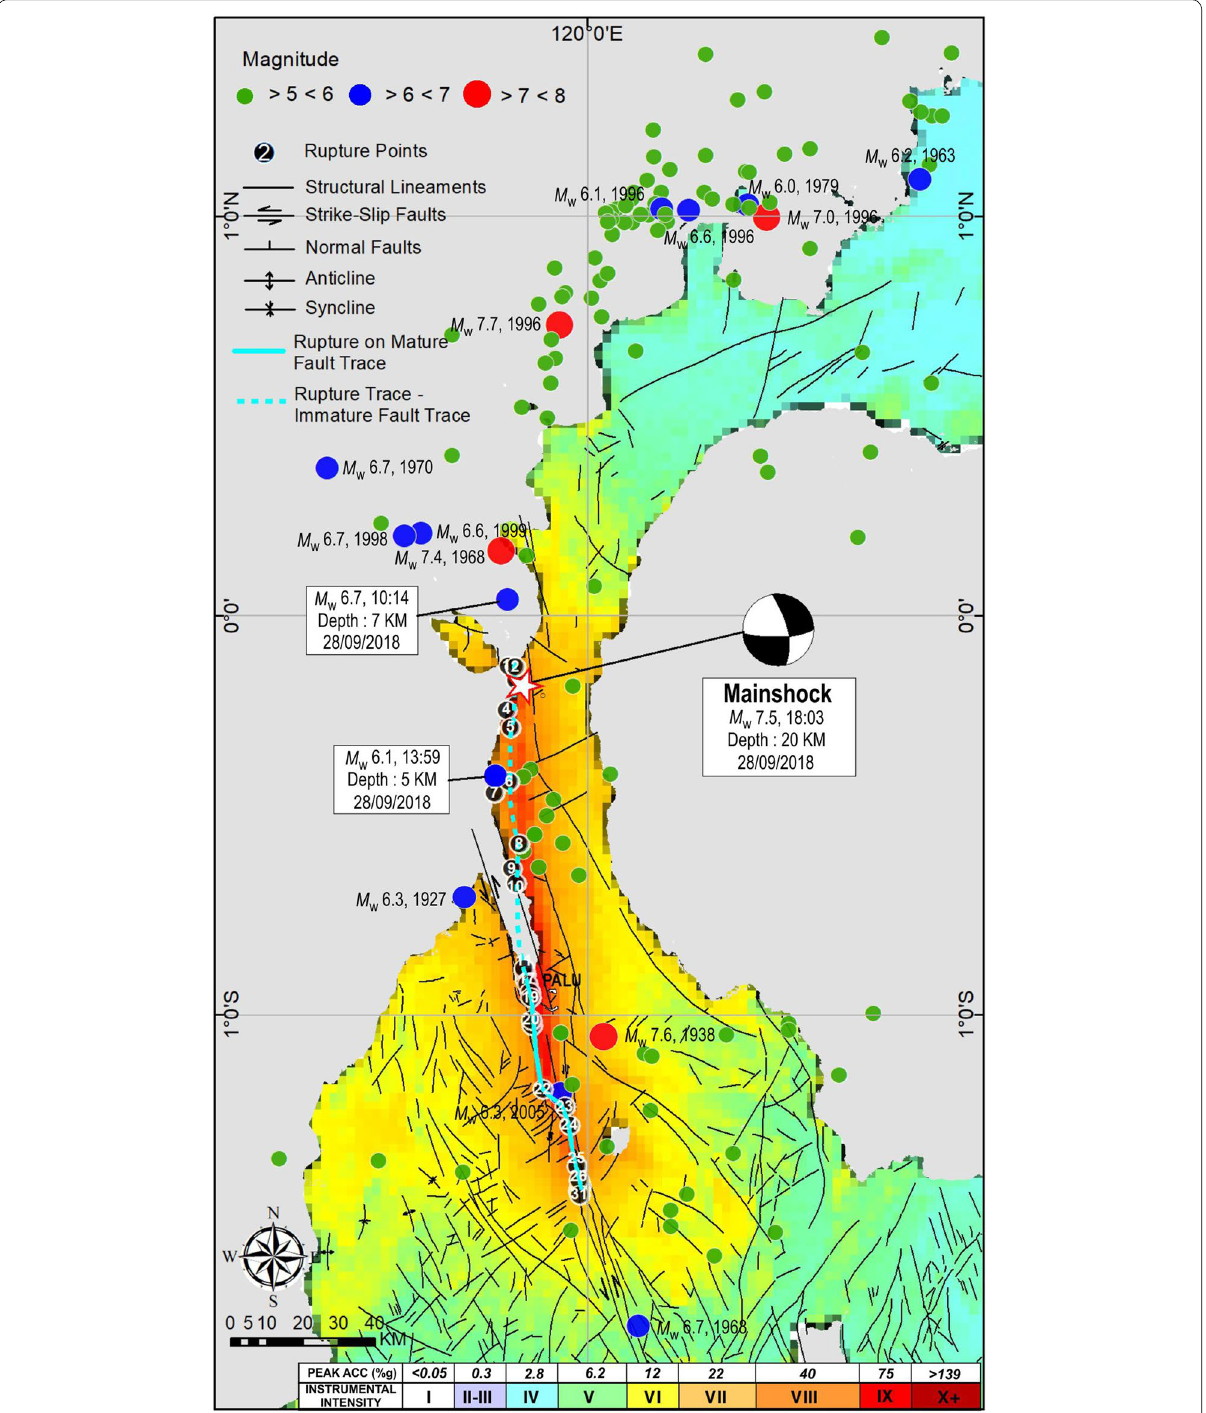
Fig. 6 Seismicity of Central Sulawesi area. Epicentres of moderate and large events (Mw 5–8) that occurred in shallow depth (< 35 km) from 1929 to 2019 are shown. Magnitude source: Pelinovsky et al. (1997); USGS, and Indonesian Earthquake Catalog, the based map: peak ground acceleration (PGA) by USGS (2018). Rupture trace inferred from radar satellite imagery is also shown as dashed line after Socquet et al. (2019). Structural lineaments are drawn after Ratman (1976), Sukamto (1973), Simandjuntak et al. (1991), Sukido et al. (1993), Watkinson (2011), Watkinson and Hall